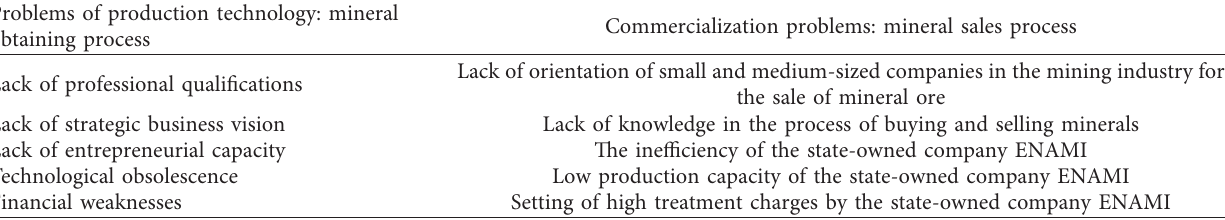
Table 1: Main problems of SME mining in